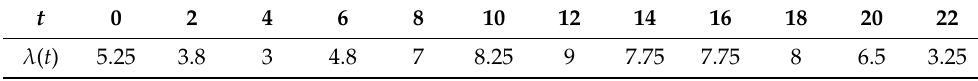
Table 2. Walk-in arrival rates.